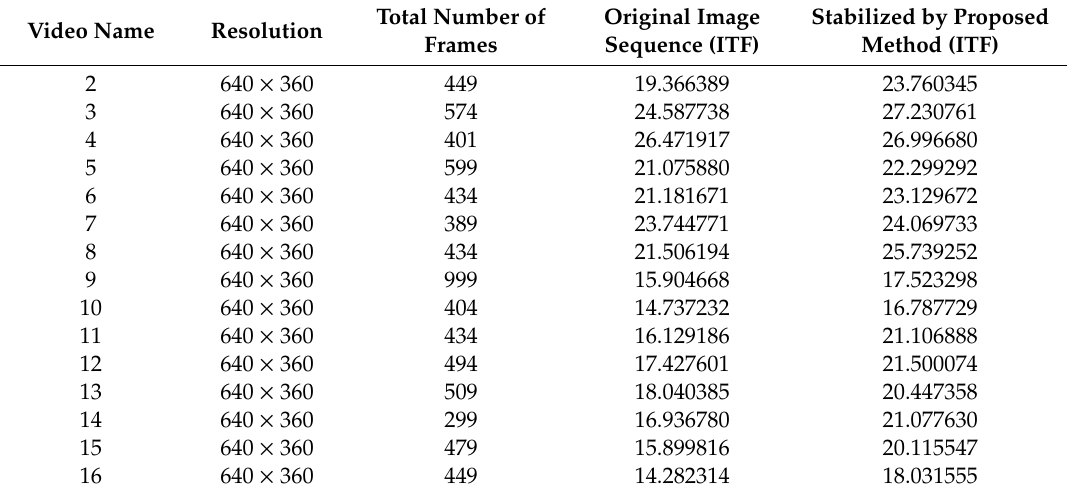
Table 4. Features and ITF values of image sequences